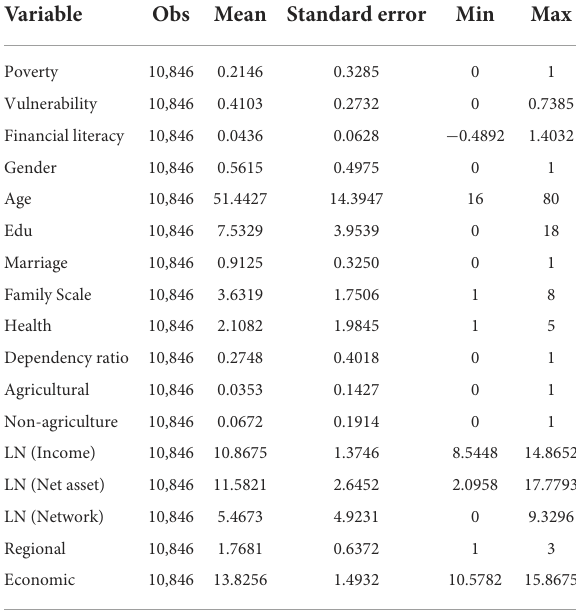
TABLE 3 Descriptive statistics of the data used in the